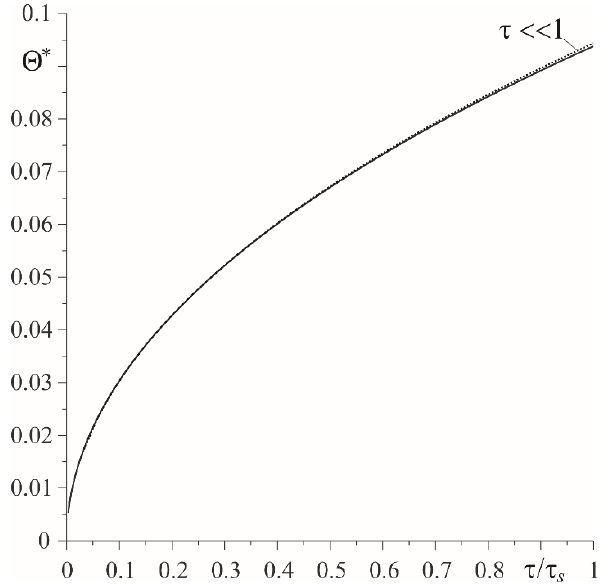
Figure 6. Change with time of the dimensionless temperature rise Θ ∗ ( τ ) on the friction surface ζ = 0 during sliding with constant velocity: exact solution—solid line; asymptotic solution—dashed line.